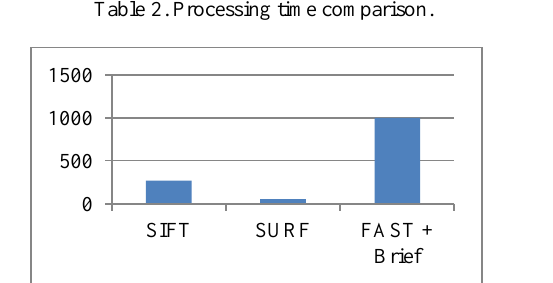
Figure 6. Matching features results.